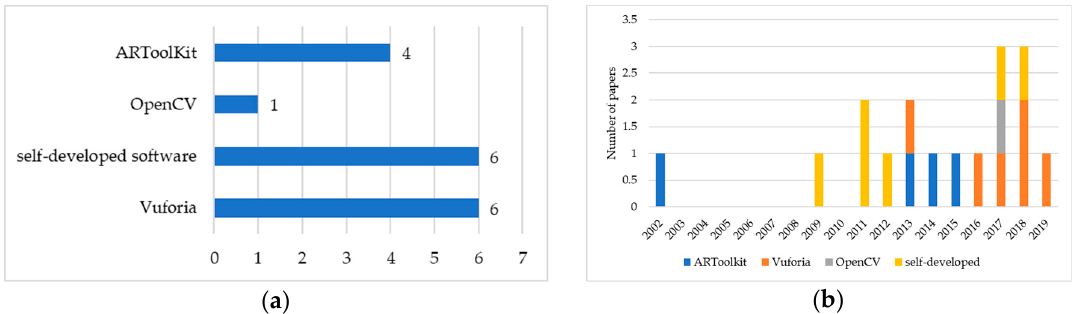
Figure 15. Distribution of work according to the AR development tool ( a ) and according to development tool per year ( b ).